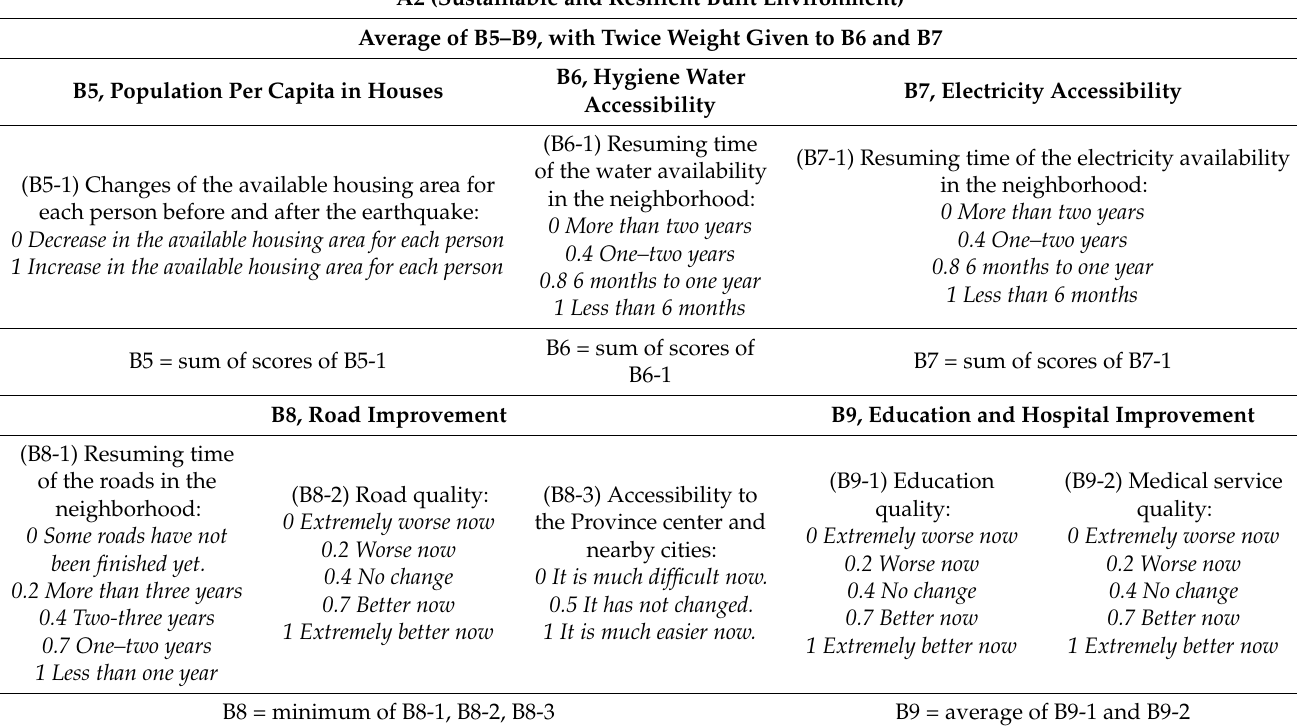
Table 3. Examples of variable